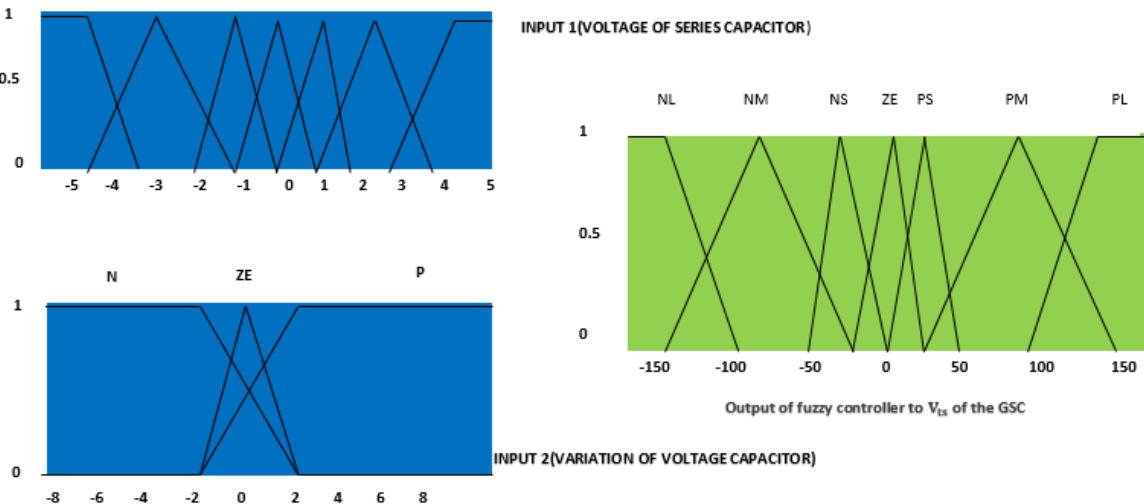
Figure 7. Inputs and output membership functions.